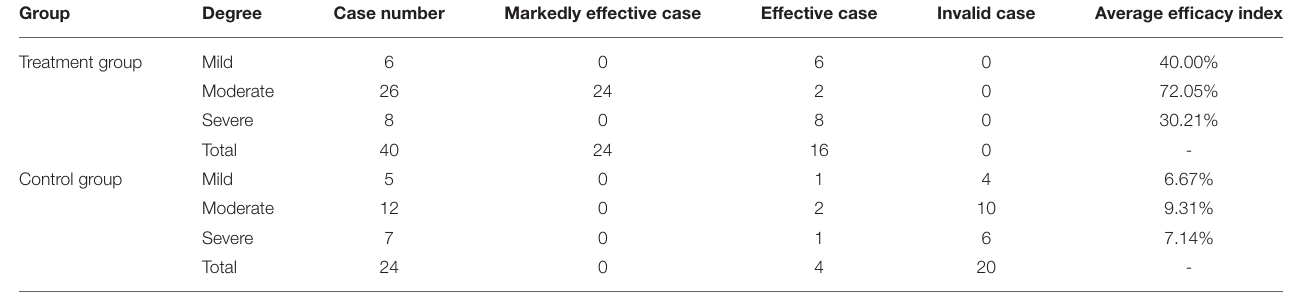
TABLE 2 | The therapeutic efficacy of acne vulgaris in two groups. Group